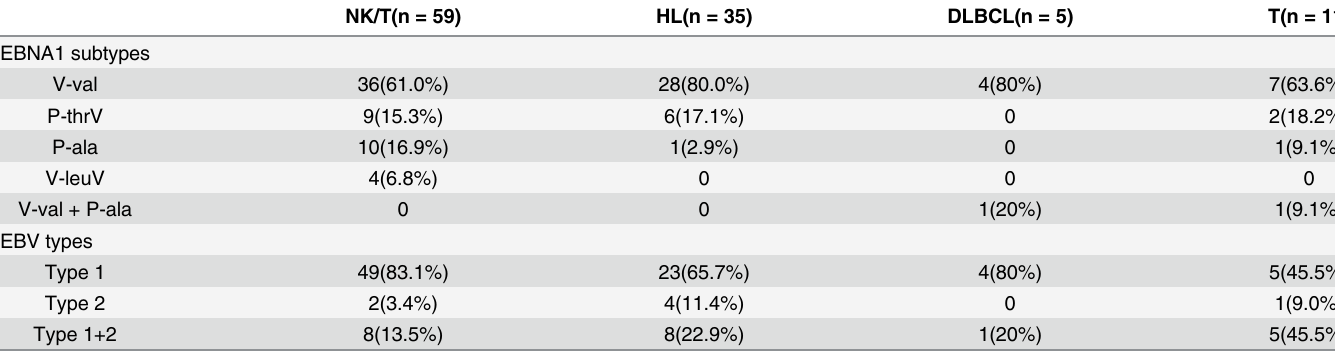
Table 1. The distribution of EBNA1 variants and EBV types in NK/T, HL, DLBCL and T cell lymphoma.